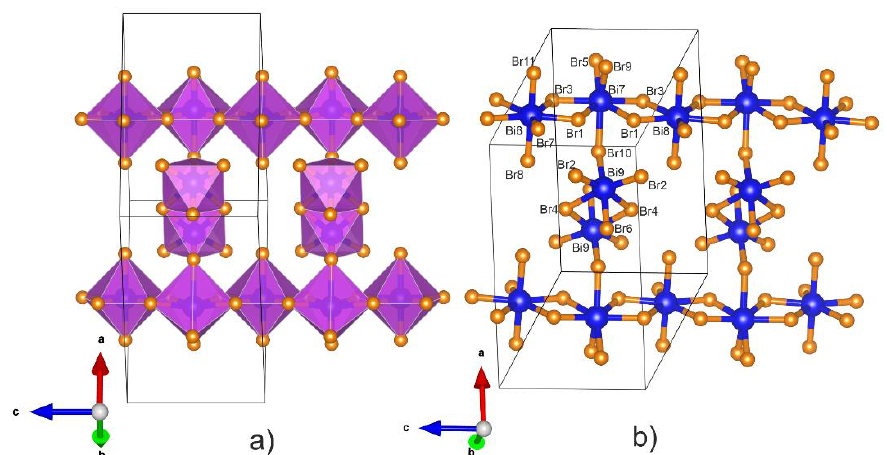
Figure 3. Anionic part of the Bi 6 Br 7 structure with 1∞ [Bi 3 Br 145- ] strands: ( a ) polyhedral representation; ( b ) ball-and-stick view.